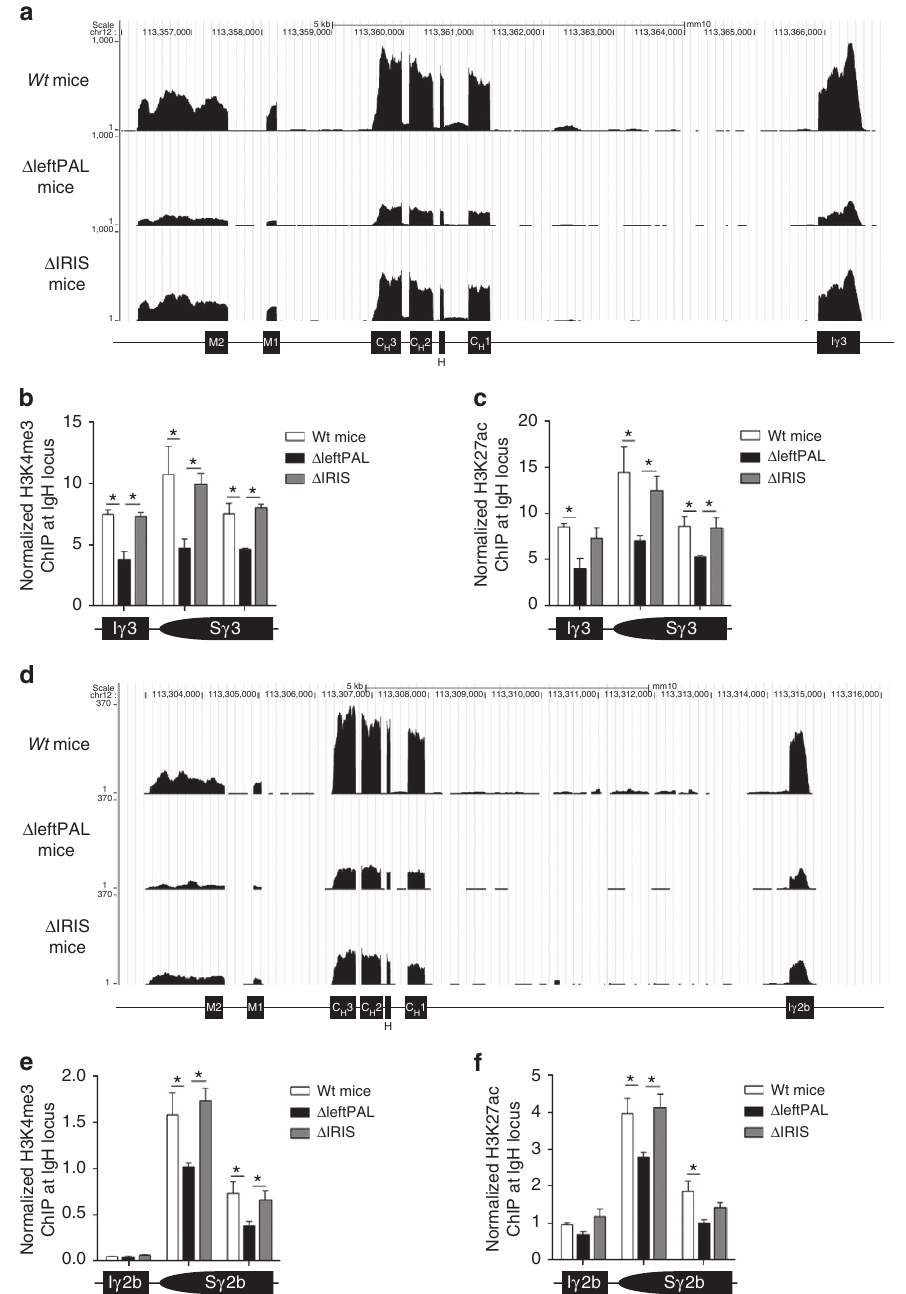
Figure 5 | Influence of the 3’RR palindrome on IgH transcription and activation of epigenetic marks during CSR. ( a ) I g 3 -C g 3 transcription in D leftPAL, D IRIS and wt mice. CD43-depleted splenocytes were cultured for 2 days with 5 m g of LPS. RNAseq experiments were performed after depletion of rRNA. Data are the mean of two independent experiments with three mice per genotype (8- to 12-week-old-male mice) ( b ) ChIP analysis of H3K4me3 in I g 3 -C g 3 in D leftPAL, D IRIS and wt mice. Data are the mean ± s.e.m. of four independent experiments (8- to 12-week-old mice, male and female). * P o 0.05